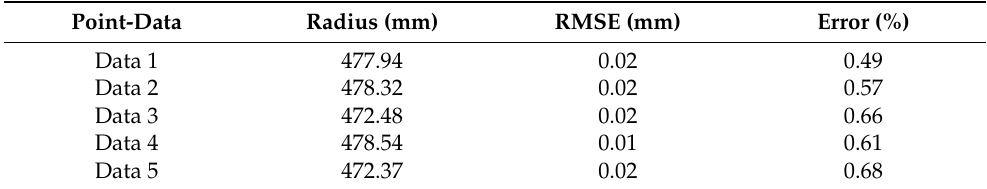
Table 1. The fitting results of measurement data and the measurement error results compared with the reference